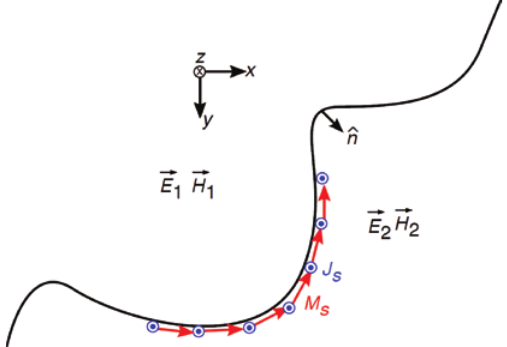
(cid:31) (cid:31) ( , ) E H is converted to 1 1 (cid:31) (cid:31) ( , ) J M sup- s s